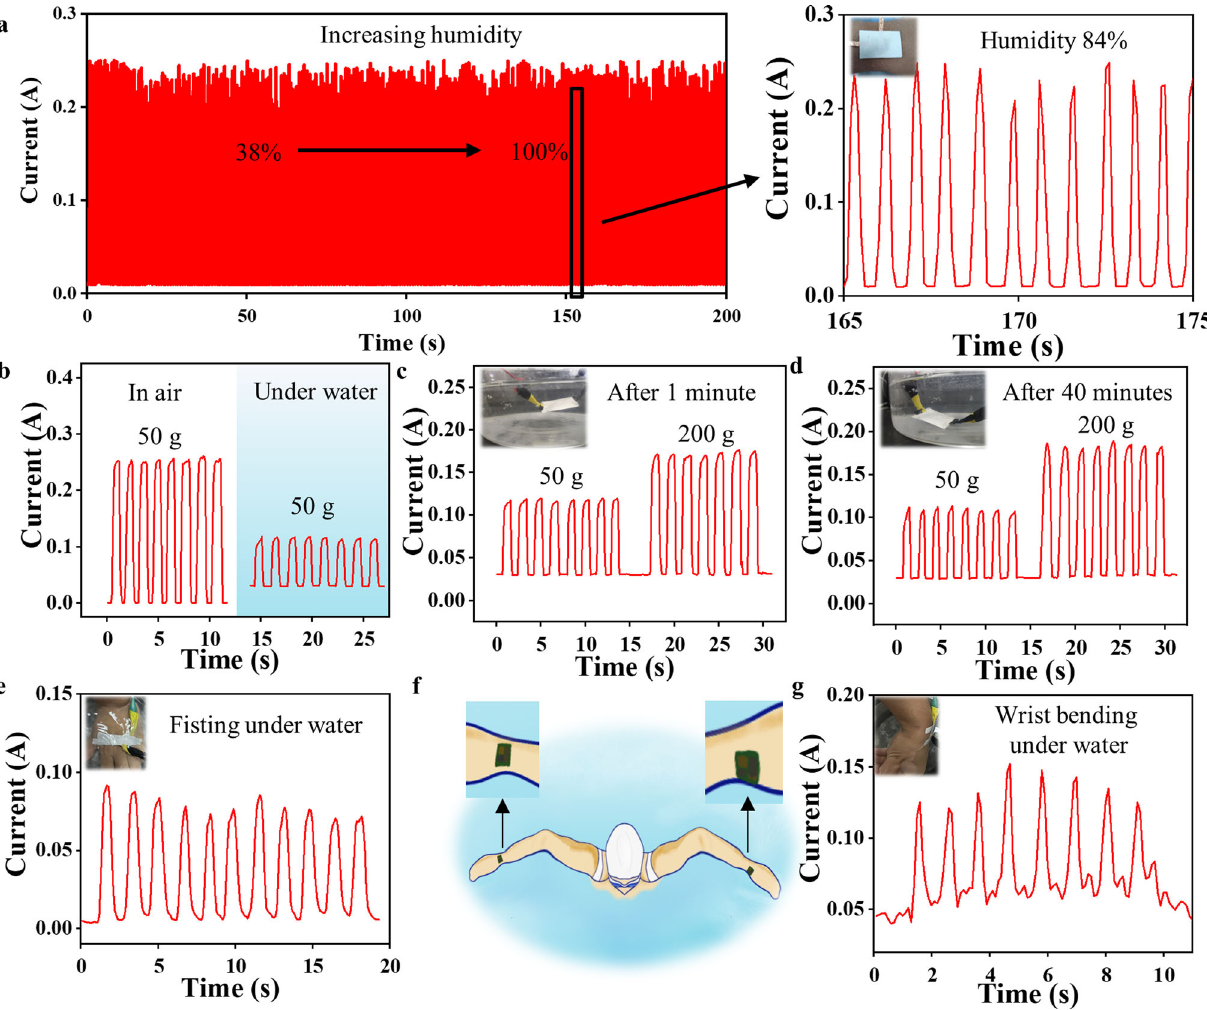
Fig. 5 Application of fully paper-based fl exible piezoresistive sensor in high humidity and water environment. a Cyclic tests of the sensor under continuously changing environmental conditions of humidity (room humidity: 38 – 100%), the enlarged data of a piezoresistive sensor in 84% humidity environment, the inset is an optical image demonstrates the sensor attached on the wrist in this test. b Cyclic tests of the sensor at 50 g weight in air and underwater environments. c Pressure response of the sensor after 1 minute in water (left: 50 g; right: 200 g). d Pressure response of the sensor after 40 minutes in water (left: 50 g; right: 200 g). e The fi sting response of the wrist under water taken by piezoresistive sensor. f Schematic diagram of sensors for monitoring human motions during swimming. g The bending response of the wrist under water taken by a fl exible piezoresistive